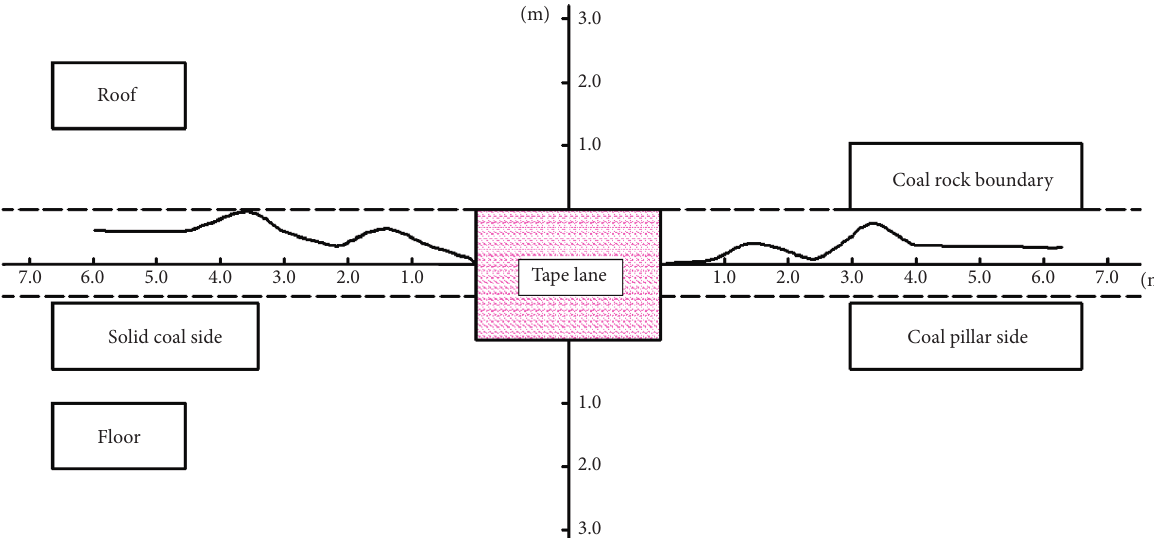
Figure 16: Schematic diagram of the surrounding rock failure stress distribution range of coal-rock interbed roadway.